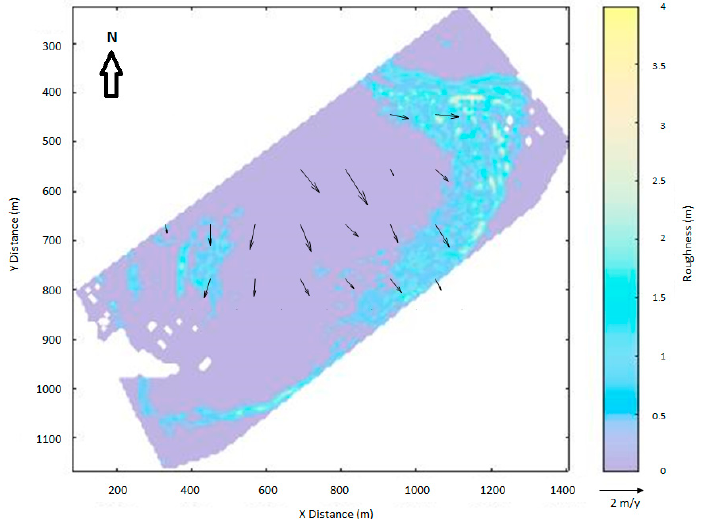
Figure 5. Suess Glacier PIV results for 200 m × 200 m gridded data. The color scale shows the glacier surface roughness (average 0.4 m). Glacier surface velocities are higher in the center of the glacier and decrease towards the edges.